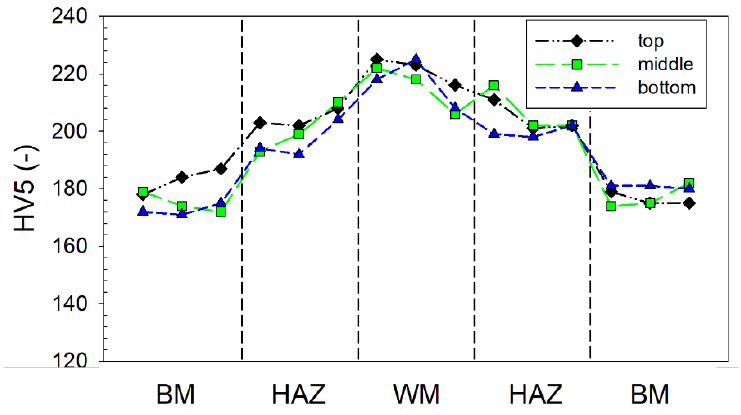
Figure 6. Course of the hardness of the HV through laser welding in the specimen.